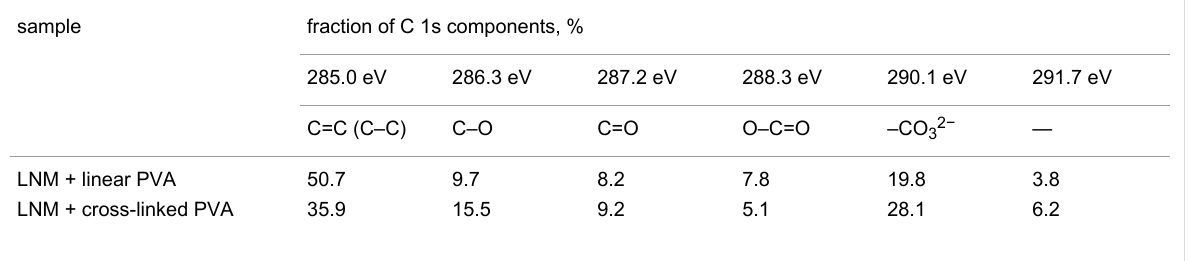
Table 1: Fractions of C 1s XPS spectra components of the LNM/C composite samples derived from the linear and cross-linked